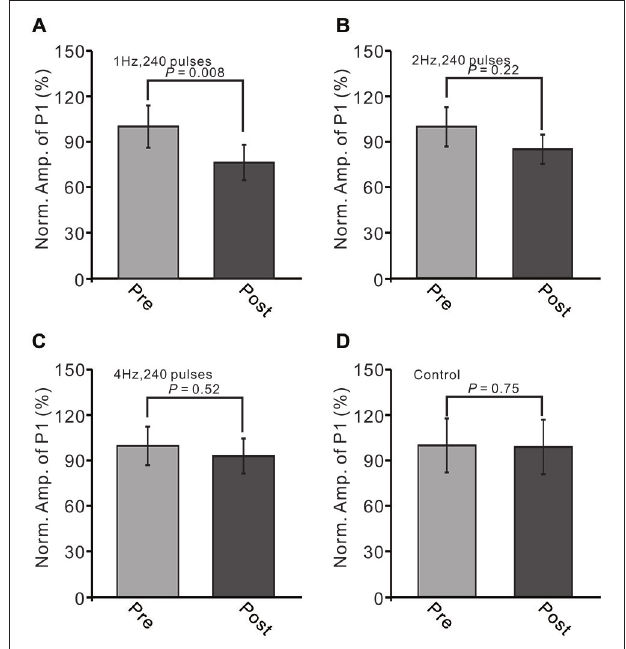
FIGURE 3 | LTD of sensory-evoked P1 at PCs was induced by 1 Hz, but not by 2 Hz or 4 Hz. (A) Bar graph showing normalized amplitude of P1 before (pre) and after (post) delivery of 2 Hz (240 pulses) stimulation. (B) Summary of data showing normalized amplitude of P1 before (pre) and after (post) 2 Hz (240 pulses) stimulation. (C) Pooled data showing normalized amplitude of P1 before (pre) and after (post) 4 Hz (240 pulses) stimulation. (D) Bar graph showing normalized amplitude of P1 under control conditions (without train of facial stimulation). Note that the amplitude of P1 was depressed after 1 Hz stimulation, but not after 2 or 4 Hz